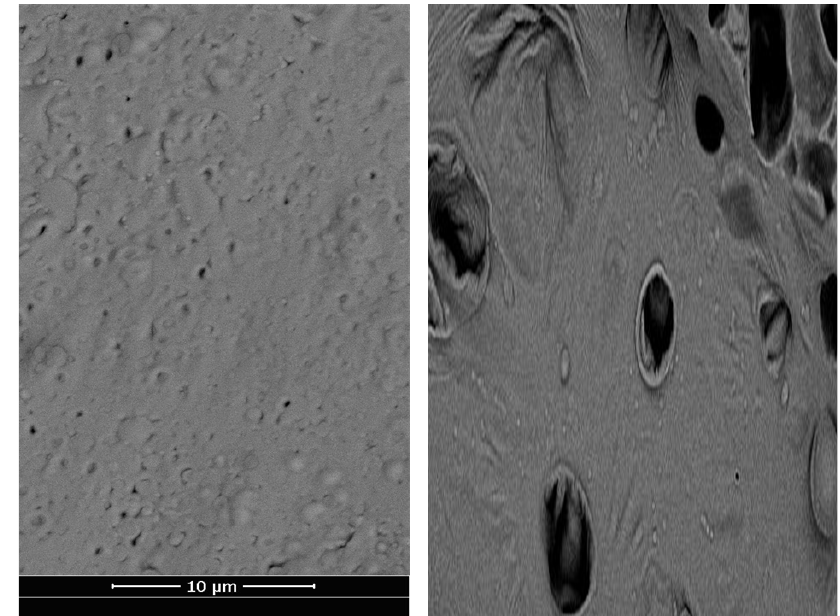
FIGURE 8 - Scanning Electron microscope of the selected SRT ODF